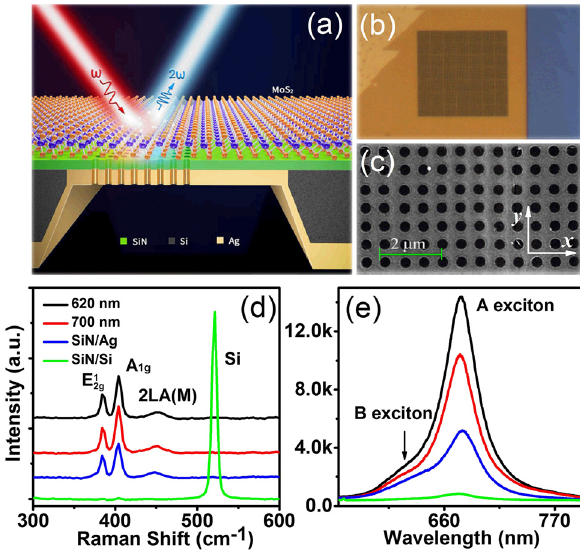
Figure 1: (a) Schematic of our designed sample for detecting second-harmonic generation (SHG) signal. (b) Optical microscope image of the sample with the size of 21.7 μ m × 21.7 μ m. (c) Scanning electron micrograph (SEM) of the structure with P = 620 nm, respectively. (d) The Raman spectra and (e) PL spectra of monolayer MoS 2 on the different